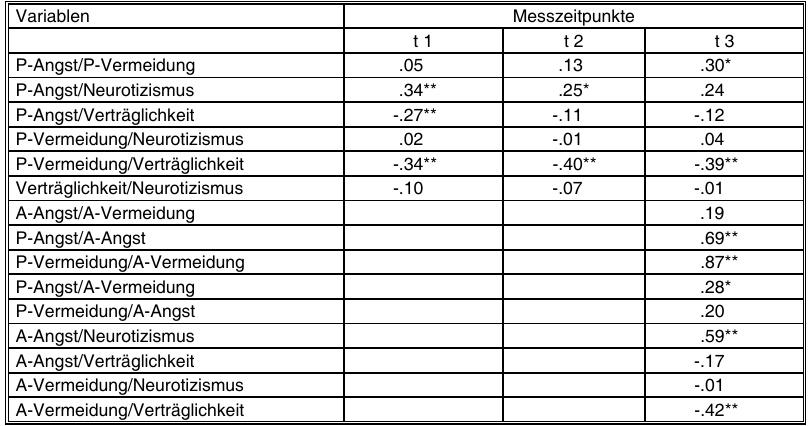
Interkorrelationen der Skalen innerhalb der